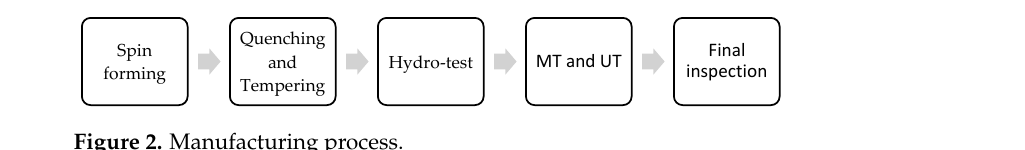
Figure 1. The dimensions of the high-pressure hydrogen storage cylinder.